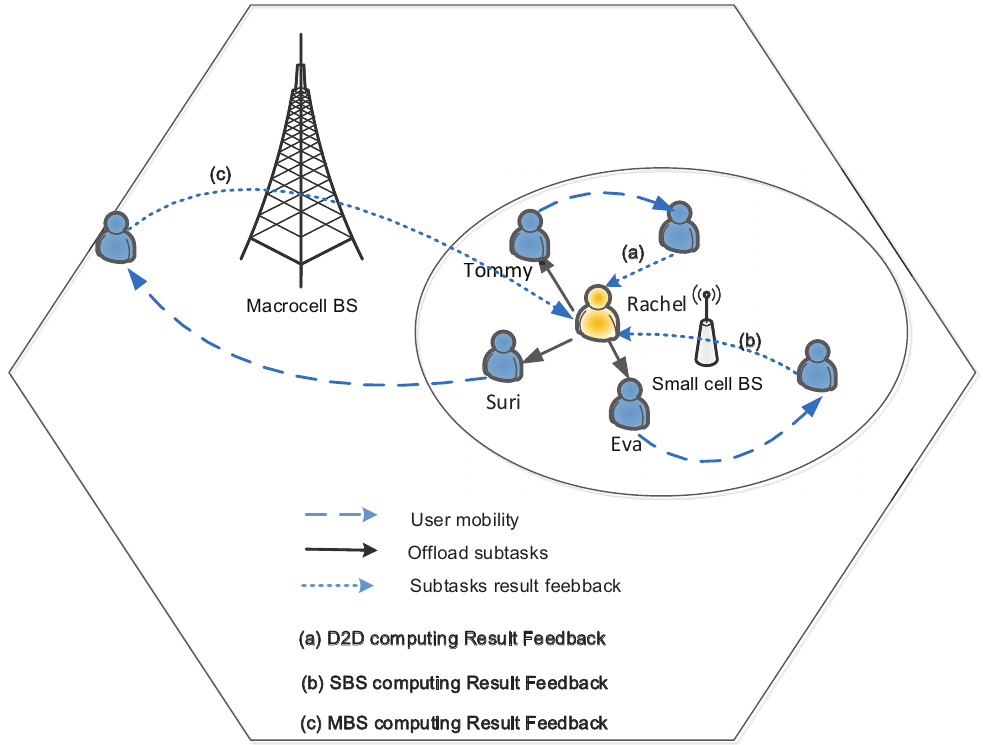
Figure 4. Illustration of the hybrid computation offloading: ( a ) Device-to-Device (D2D) computing result feedback; ( b ) Small cell Base Station (SBS) computing result feedback; ( c ) Macrocell Base Station (MBS) computing result